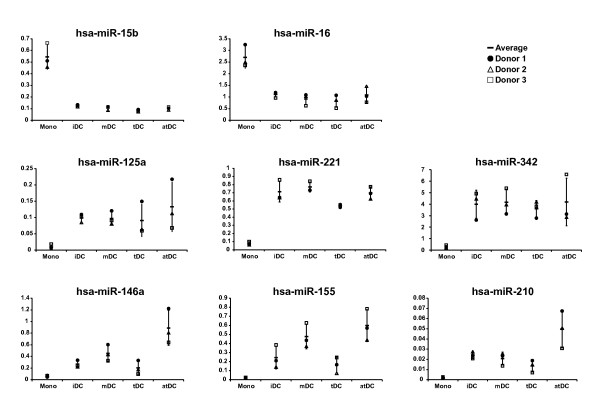
Expression profiles of various miRNAs that are differentially expressed in monocytes and DCs. The upper two charts represent miRNAs over-expressed in monocytes, the middle row of charts represent 3 of the miRNAs over-expressed in DCs, and the lower row of charts represent the 3 miRNAs that are differentially expressed among subsets of DCs. On the Y-axis relative expression is depicted, which is normalized to the expression of hsa-let-7a.